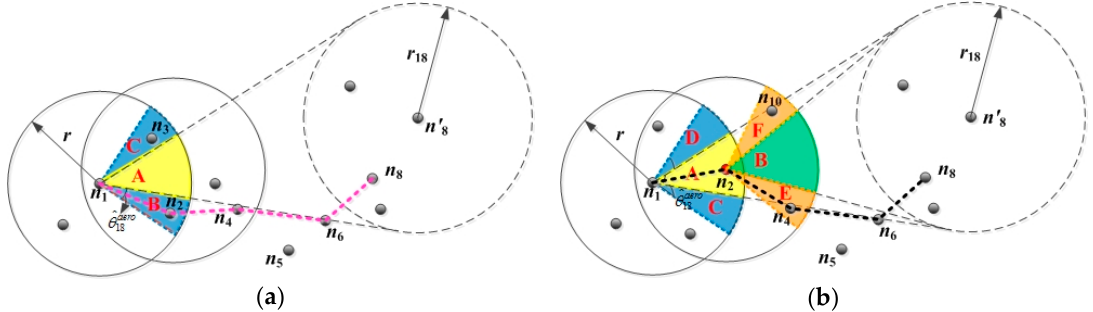
=∅ ; ( b ) in the situation of